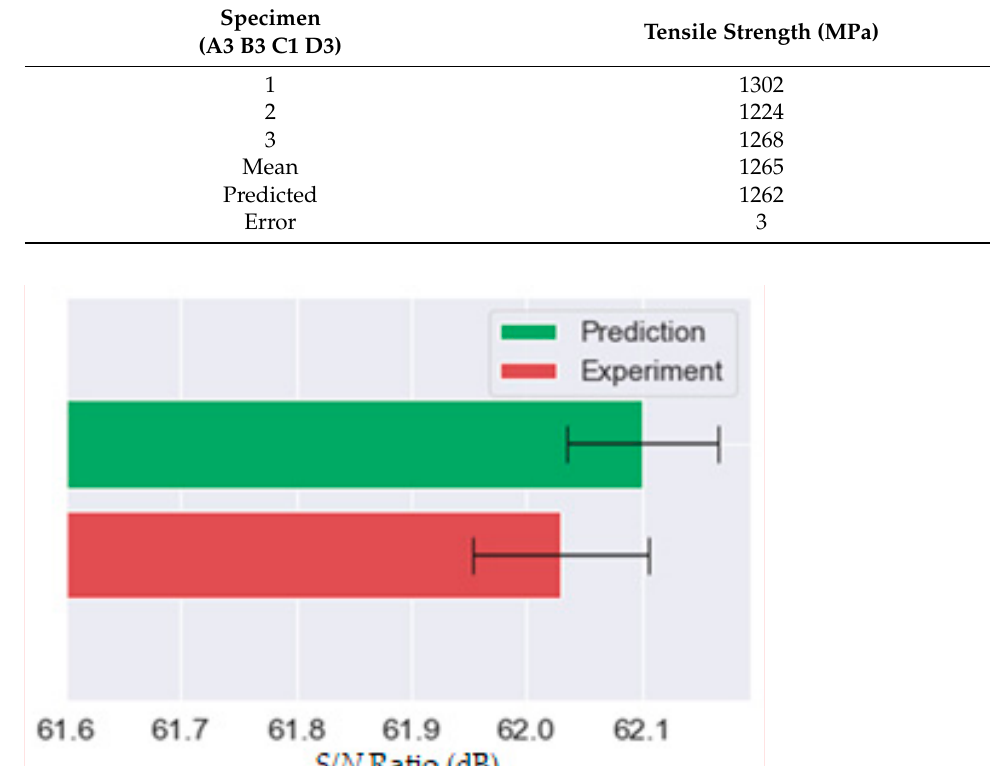
Table 7. Verification of the optimization of tensile strength.